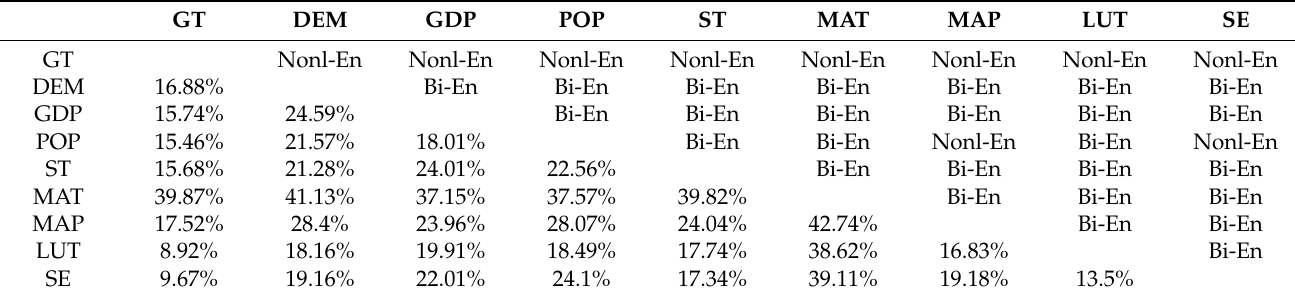
Table 3. Influence of the interaction between pairs of factors